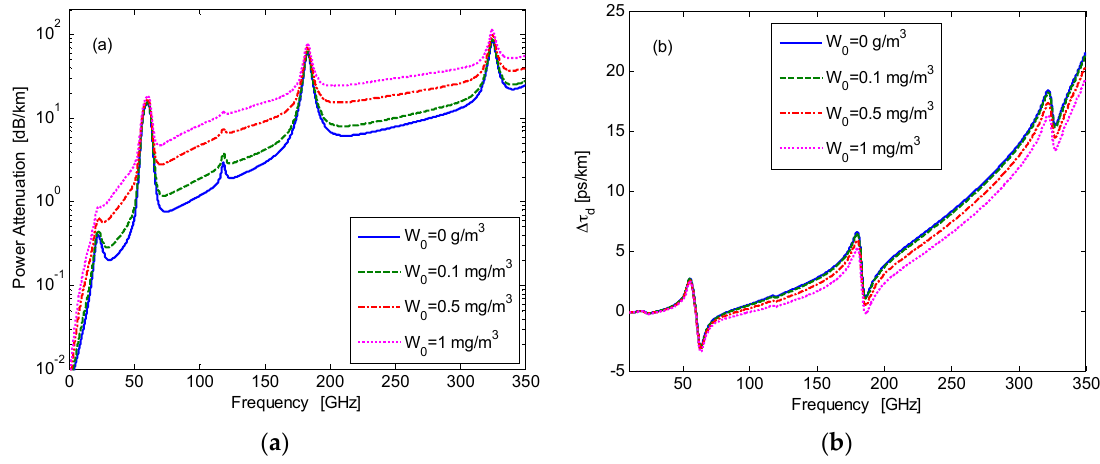
Figure 1. Atmospheric propagation factor in the EHF band: ( a ) attenuation coefficient 20log( ) e f in (dB/km); ( b) group delay increment ' / N f d c in (ps/km).